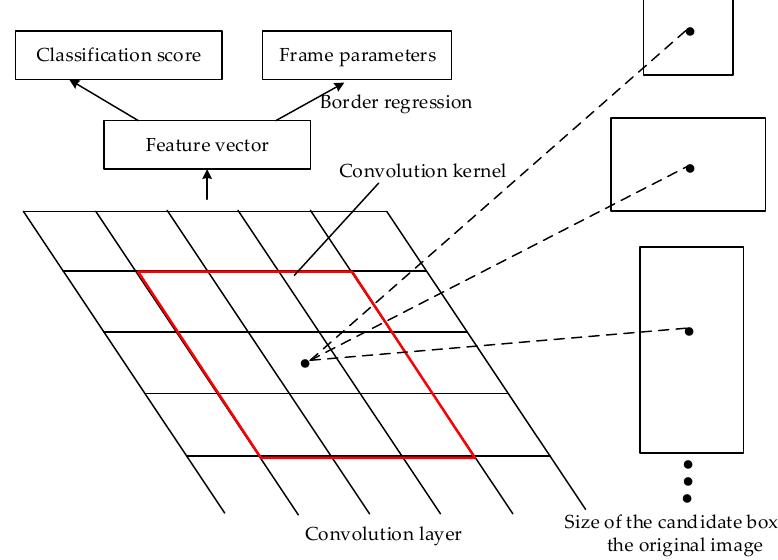
Figure 2. Extraction of candidate frames with different sizes.